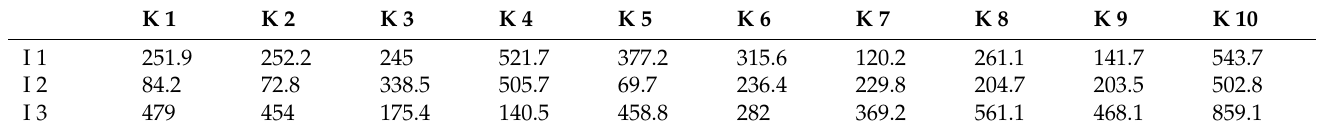
Table A2. Distance between manufacturing plant I and sales/collection center K (km).